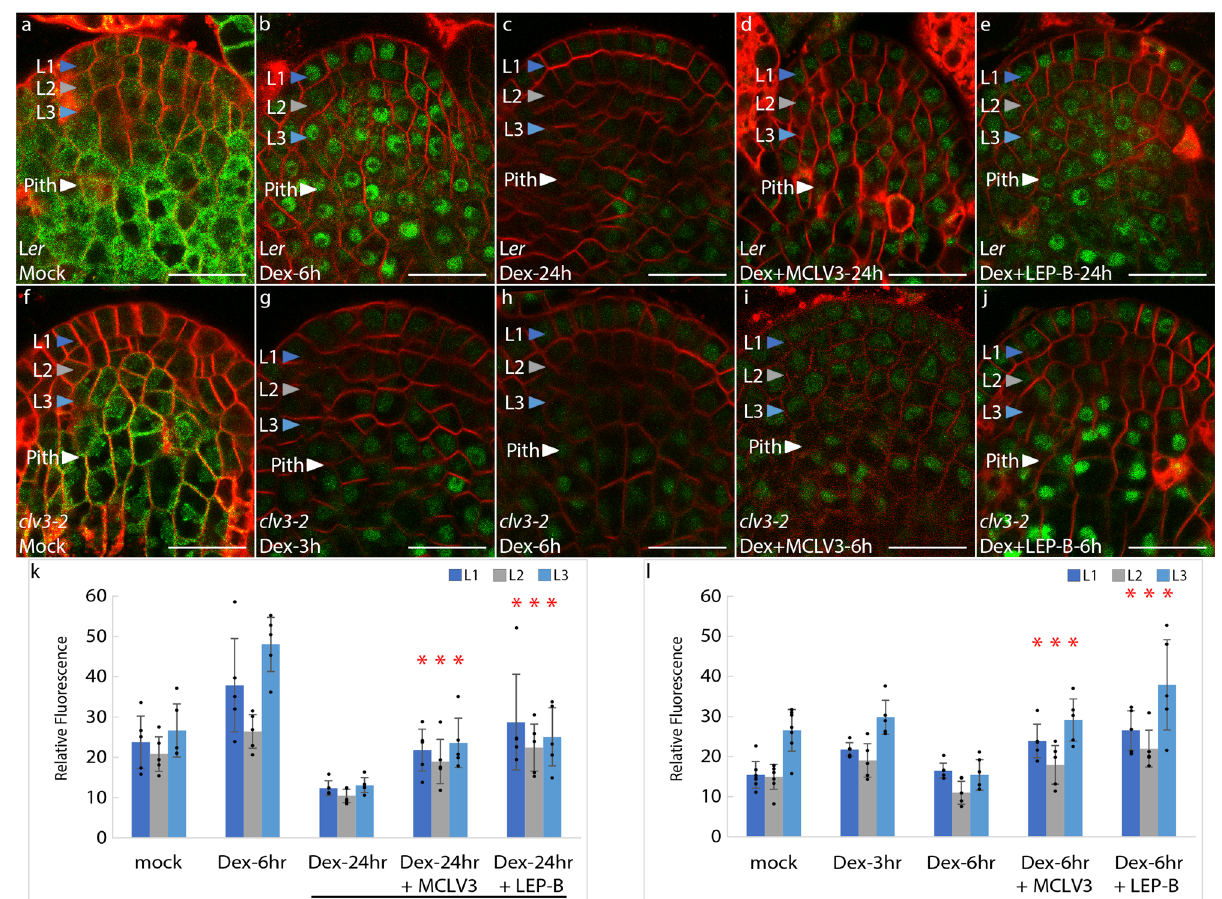
Fig. 3 Nuclear stabilization of transiently translocated eGFP-WUS-GR protein upon MCLV3 peptide and Leptomycin-B treatments. p35S:: eGFP-WUS- GR reporter response in 7-day old a mock-treated ( n = 5), b short-term [6 h] Dex-induction ( n = 5), c long-term [24 h] Dex-induction ( n = 5), d long-term Dex-induction [24 h] co-treated with 1 μ M MCLV3 ( n = 5), and e long-term Dex-induction [24 h] co-treated with 20 nM LEP-B ( n = 5) in wild-type SAMs. p35S:: eGFP-WUS-GR reporter response in 7-day old f mock-treated ( n = 7), g short-term [3 h] Dex-induction ( n = 5), h long-term [6 h] Dex-induction ( n = 5), i long-term Dex-induction [6 h] co-treated with 1 μ M MCLV3 ( n = 5), and j long-term Dex-induction [6 h] co-treated with 20 nM LEP-B ( n = 5) in clv3-2 SAMs. The “ n ” represents the number of independently treated plants. k , l Quanti fi cation of p35S:: eGFP-WUS-GR fl uorescence levels (mean ± s.d.) in k wild type or l clv3-2 SAMs from experiments shown in a – j . The * represents a p value ≤ 0.05 when compared to WUS levels from corresponding Dex treatments (Dex-24 h for wild type and Dex-6 h for clv3-2 ) from the same cell layer (Student ’ s two-tailed t- test). Error bars represent the standard deviation (s.d.). eGFP (green) is overlaid on FM4-64 (red) plasma membrane stain. Scale bars = 20 μ